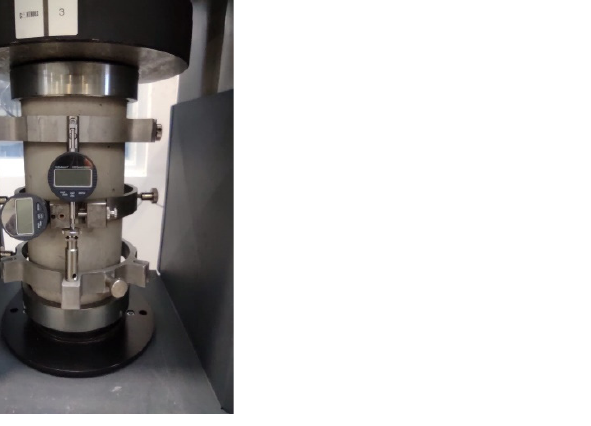
Figure 4. Equipment used for the static elasticity modulus and the static Poisson ratio